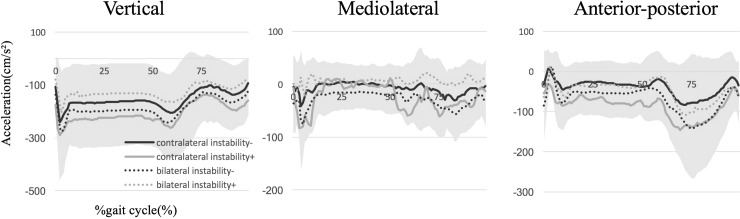
The average wave patterns of accelerations along three axes, including vertical (VT, positive superiorly), mediolateral (ML, positive medially), and anteroposterior (AP, positive anteriorly) directions among four groups with or without subjective instability in the contralateral or bilateral implanted knees, are shown.The colored range means standard deviation (SD) in all groups.